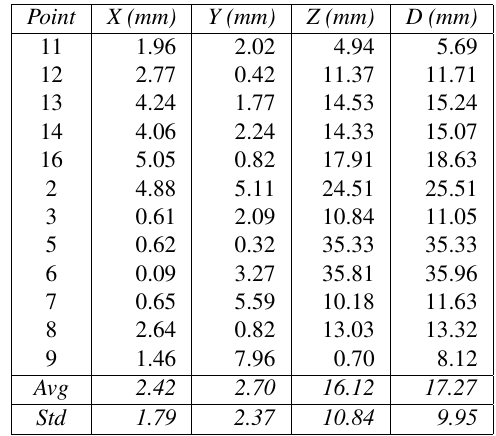
Table 4. Residual of CPs in detail of Case 2-Method